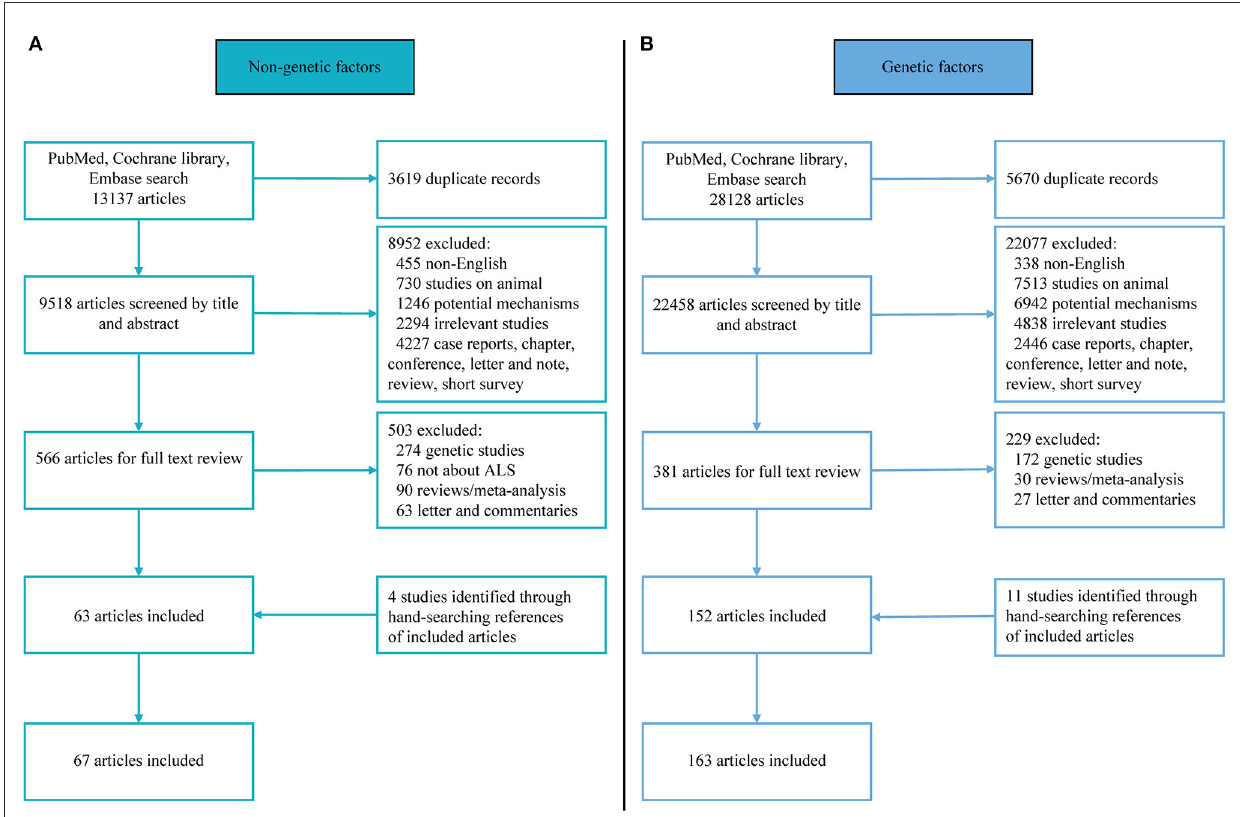
FIGURE1 Flowchart of literature selection. (A) Flowchart of non-genetic literature selection; (B) flowchart of genetic literature selection.